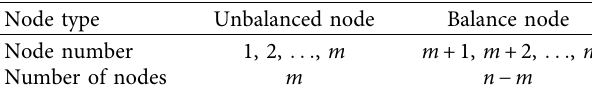
Table 2: Node number of natural gas